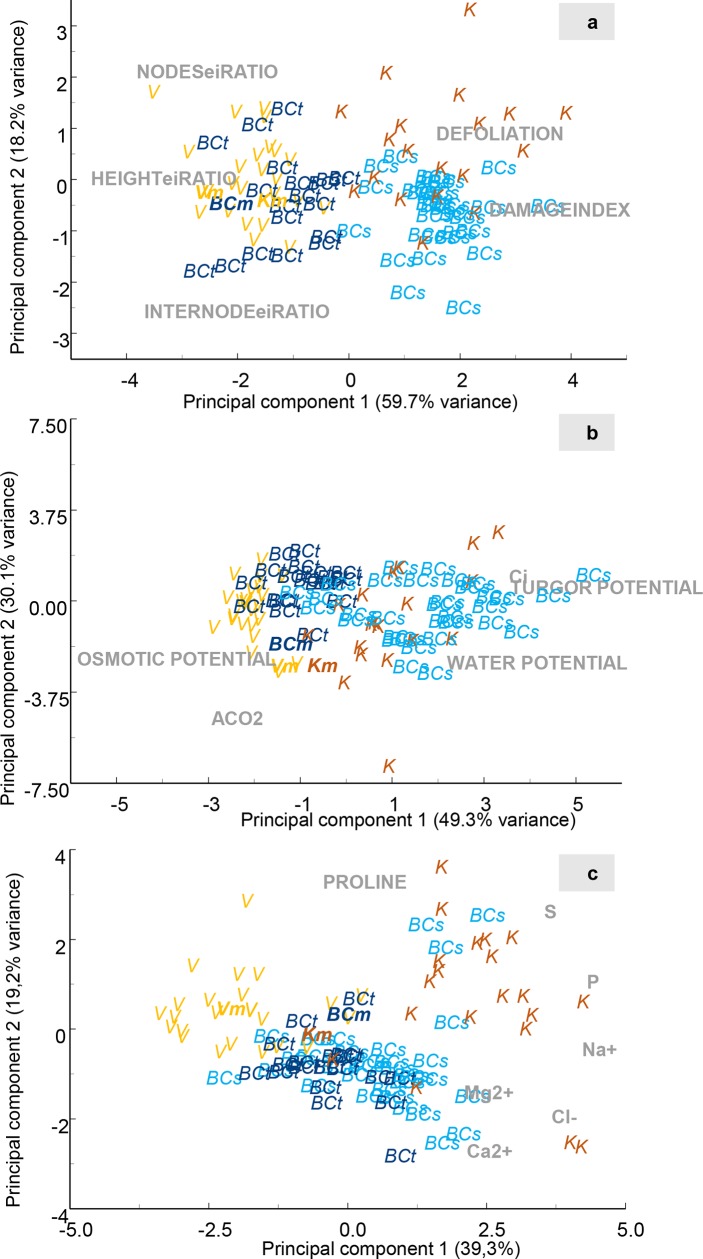
Plot of the first two components from a principal component analysis of morphological variables (a), leaf gas exchange and leaf water relations (b) ionic and proline content (c) of the three populations under saline conditions. Each population represented by letters: V–D. virginiana population (yellow), K–D. kaki population (brown) and BC–Backcross population (blue). BCt are the Backcross plants that showed a salt tolerant phenotype and BCs the plants salt sensitive. Vm, Km and BCm in bold represents the mean of the individuals under control treatment. Gray letters represent each of the measured variables.